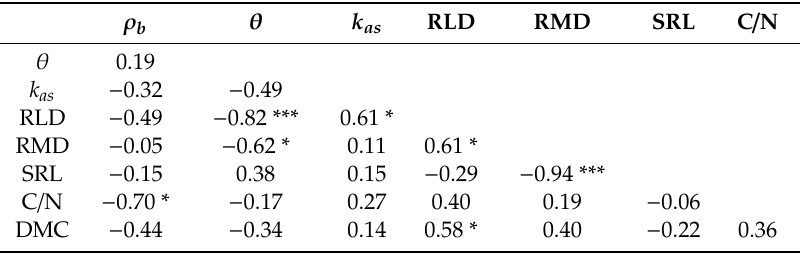
Table 4. Pearson correlation matrix of soil physical properties and root traits. All traits and soil properties were log-transformed. ρ b θ k as RLD RMD ρ b